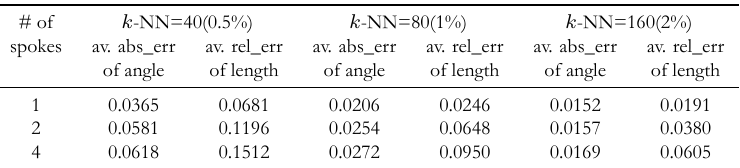
Table 1: Results of ℓ 1 MCDA on Gaussian-based radial data sets